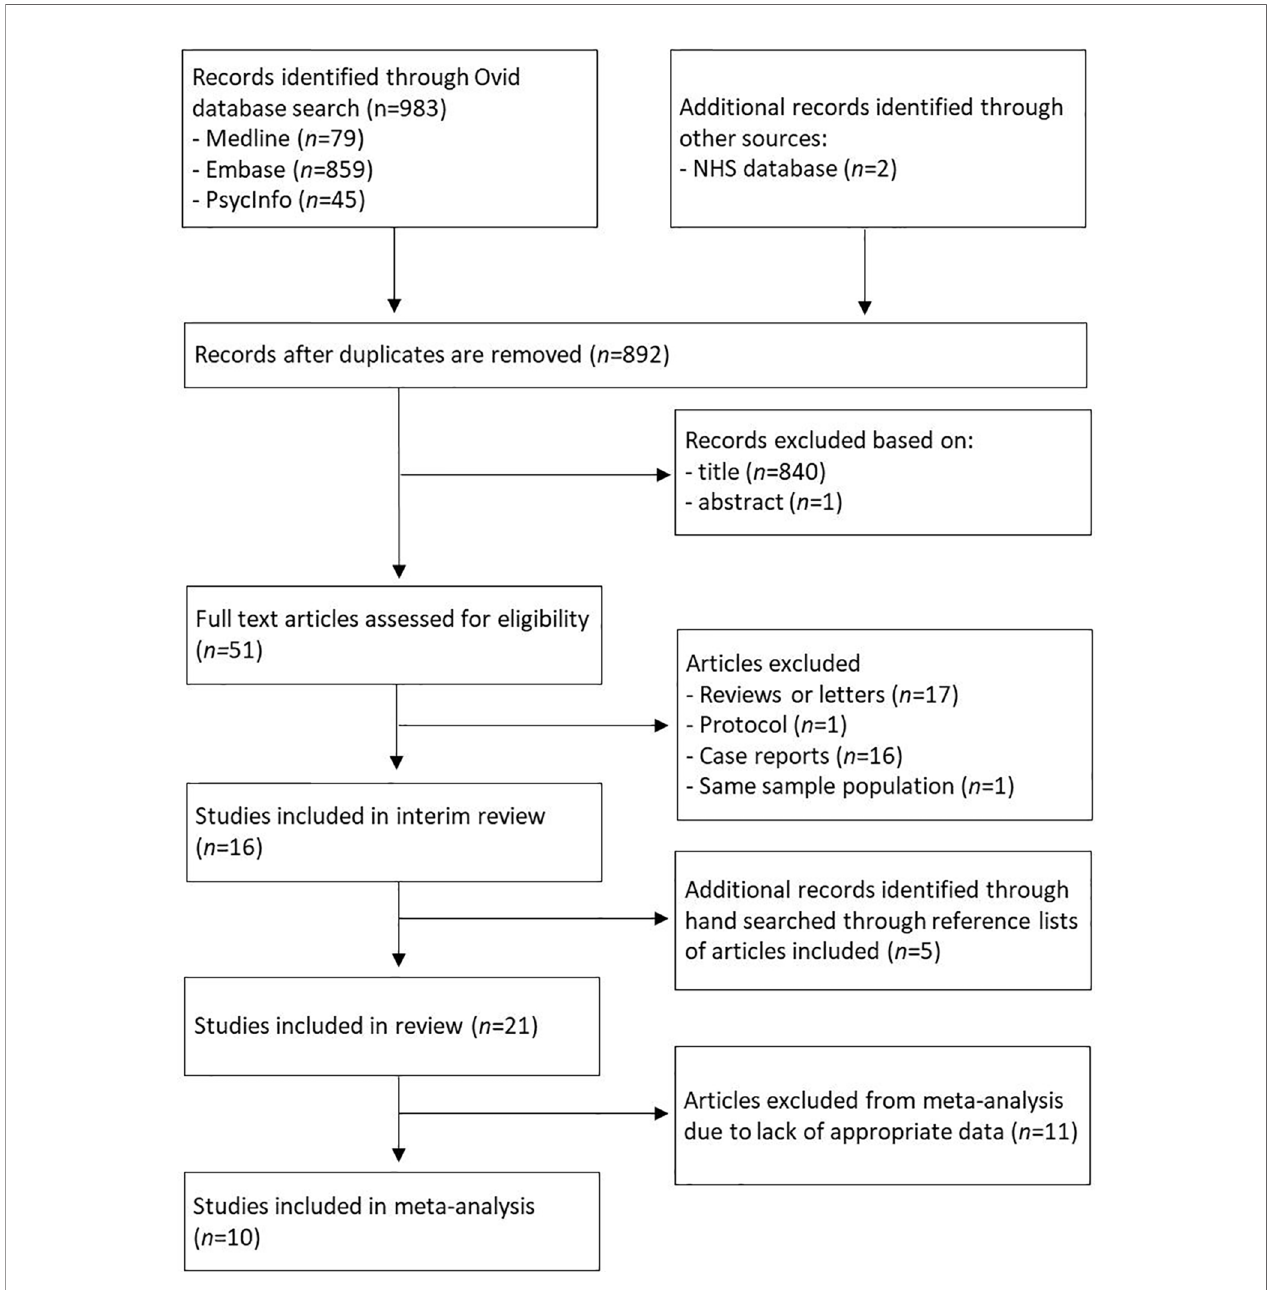
FIGURE 1 | Flow chart of studies included in systematic